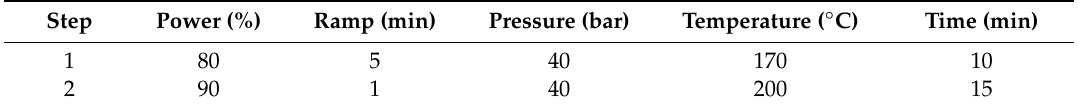
Table 3. Parameters of digestion